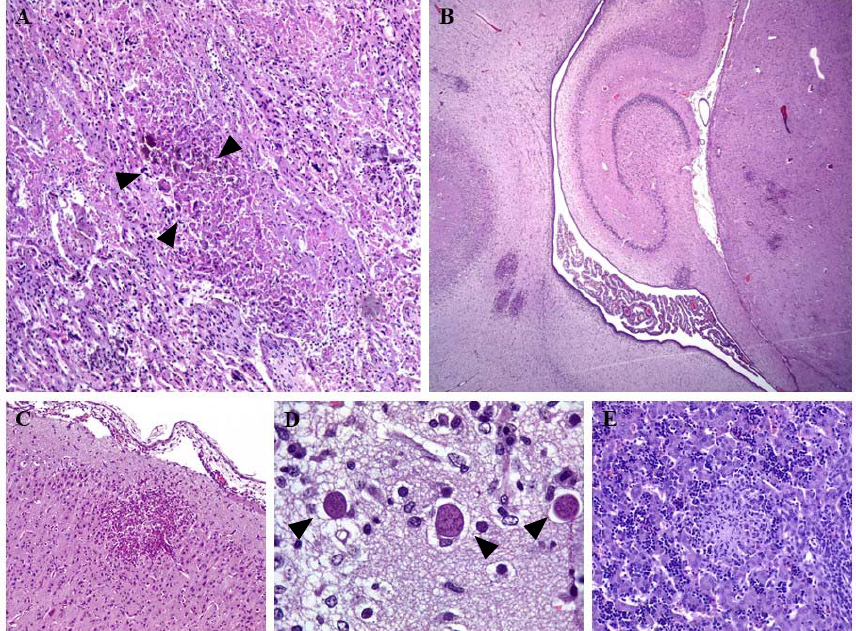
Figure 1. Microscopic lesions of ovine neosporosis. ( A ) Placenta. Focus of necrosis and scant infiltration of inflammatory cells, mainly lymphocytes and macrophages, within the maternal–fetal interface area of the placenta. Note mineralization at the center of the necrotic area (deep purple- pigment, arrowheads); HE. 4 × . ( B ) Fetal brain; encephalitis characterized by multifocal glial foci randomly distributed within the neuropil; HE. 2 × . ( C ) Fetal brain; higher magnification of the mononuclear glial foci within the grey matter of the cerebral cortex. There is mild mononuclear cell inflammation within the adjacent meninges; HE. 4 × . ( D ) Fetal brain; parasite tissue cysts (arrowheads) within the neuropil. Note the scant inflammatory cell reaction in relation to the tissue cysts; HE. 40 × . ( E ) Fetal liver; focus of caseous necrosis and infiltration of mononuclear cells—mainly macrophages—within the hepatic parenchyma. The aggregates of dark, mononuclear cells are foci of hematopoietic tissue—a normal finding in the fetal liver; HE. 10 ×